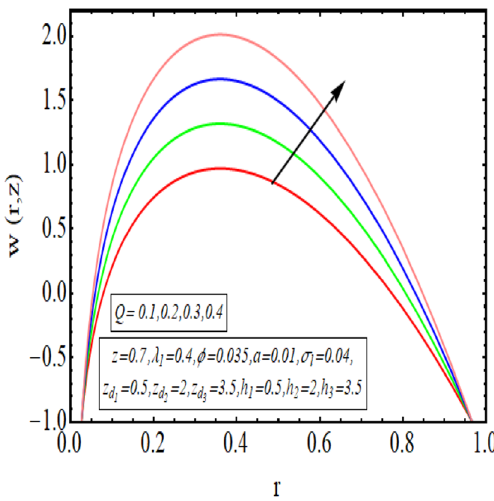
Figure 3. Velocity for Q .